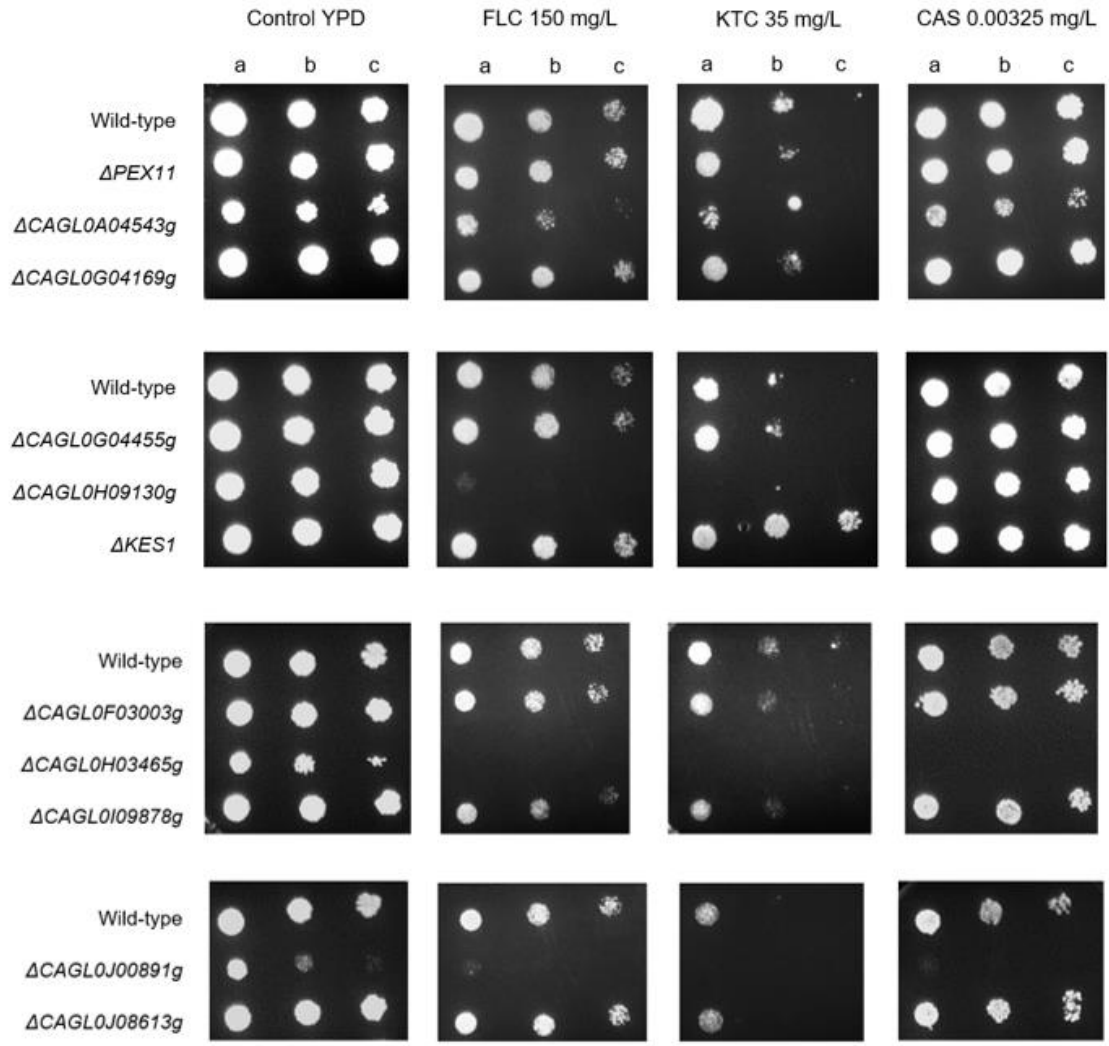
FIGURE 6. Comparison of the susceptibility to antifungal azole drugs and caspofungin, at the indicated concentrations, of the C. glabrata KEU100 wild-type strain or derived single mutant strains on YPD agar plates by spot assays. The inoculum